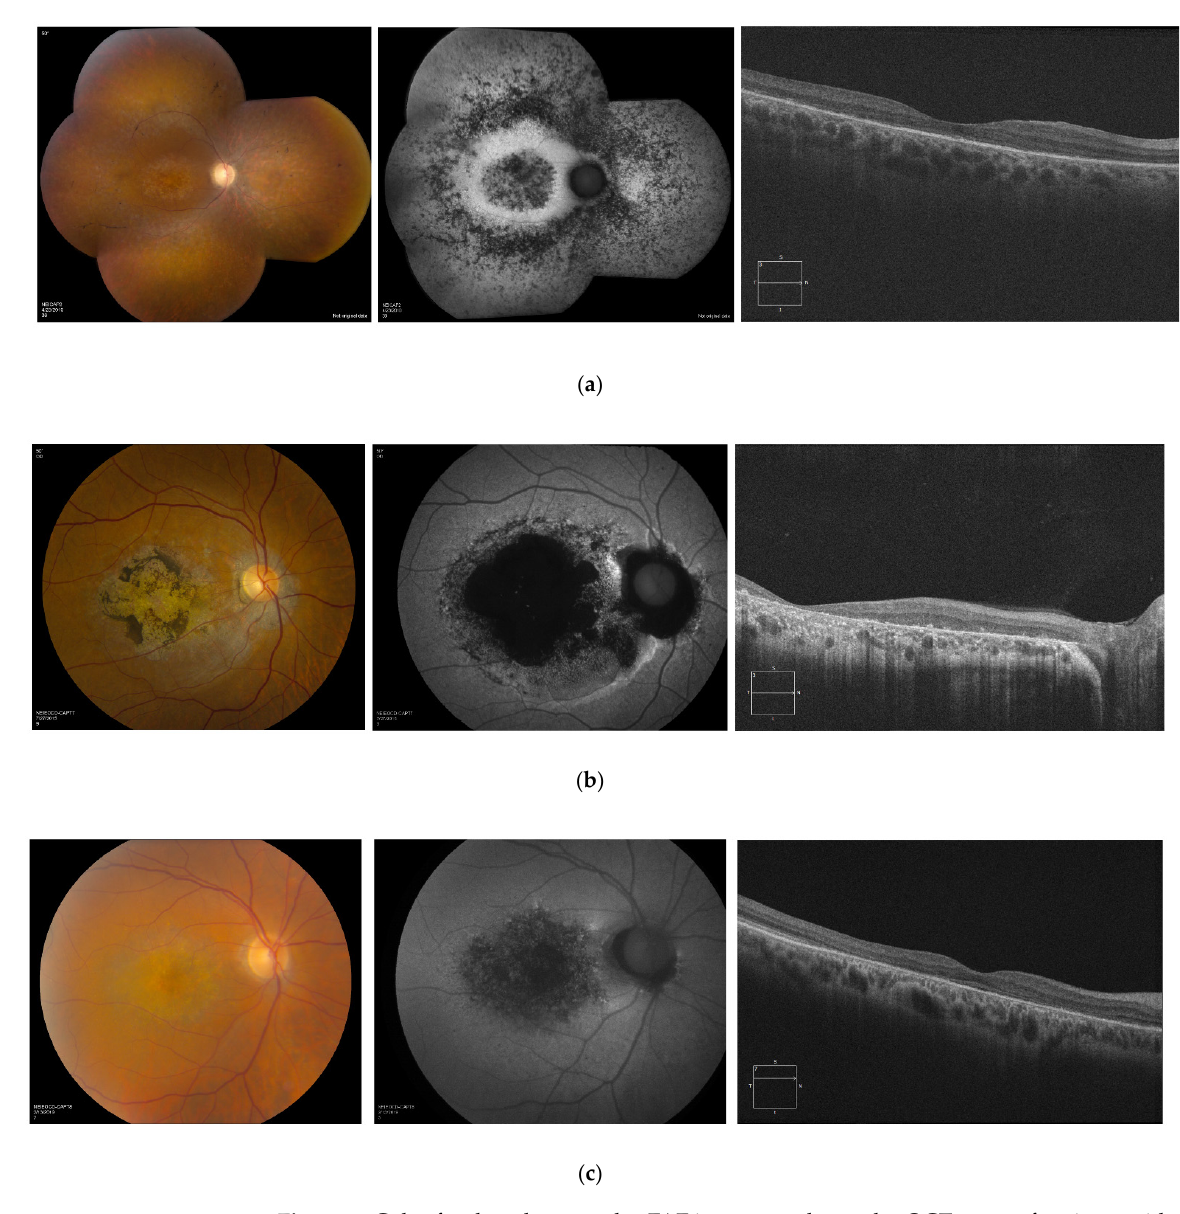
Figure 3. Color fundus photographs, FAF images, and macular OCT scans of patients with ( a ) RCD, ( b ) CRD, and ( c ) LOMD. Note: ( a ) the early macular involvement in a 28-year-old female with RCD diagnosis; ( b ) the clinical findings of an extensive macular atrophy and pigmentation with a reduction in photopic and mildly subnormal scotopic ERG responses in a patient with CRD; ( c ) bilateral macular atrophy and diffuse generalized hypoautofluorescence, normal rod with reduced cone ERG responses in a patient with LOMD. FAF, fundus autofluorescence; OCT, optical coherence tomography; RCD, rod–cone dystrophy; CRD, cone–rod dystrophy; LOMD, late-onset macular dystrophy; ERG,